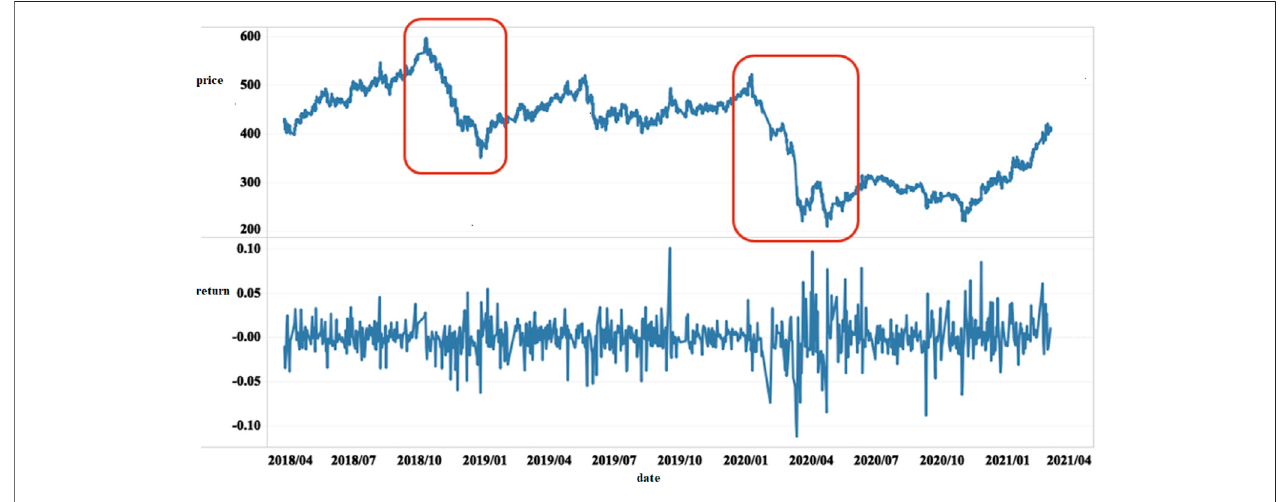
FIGURE 1 | Time series of China ’ s crude oil futures market price and return